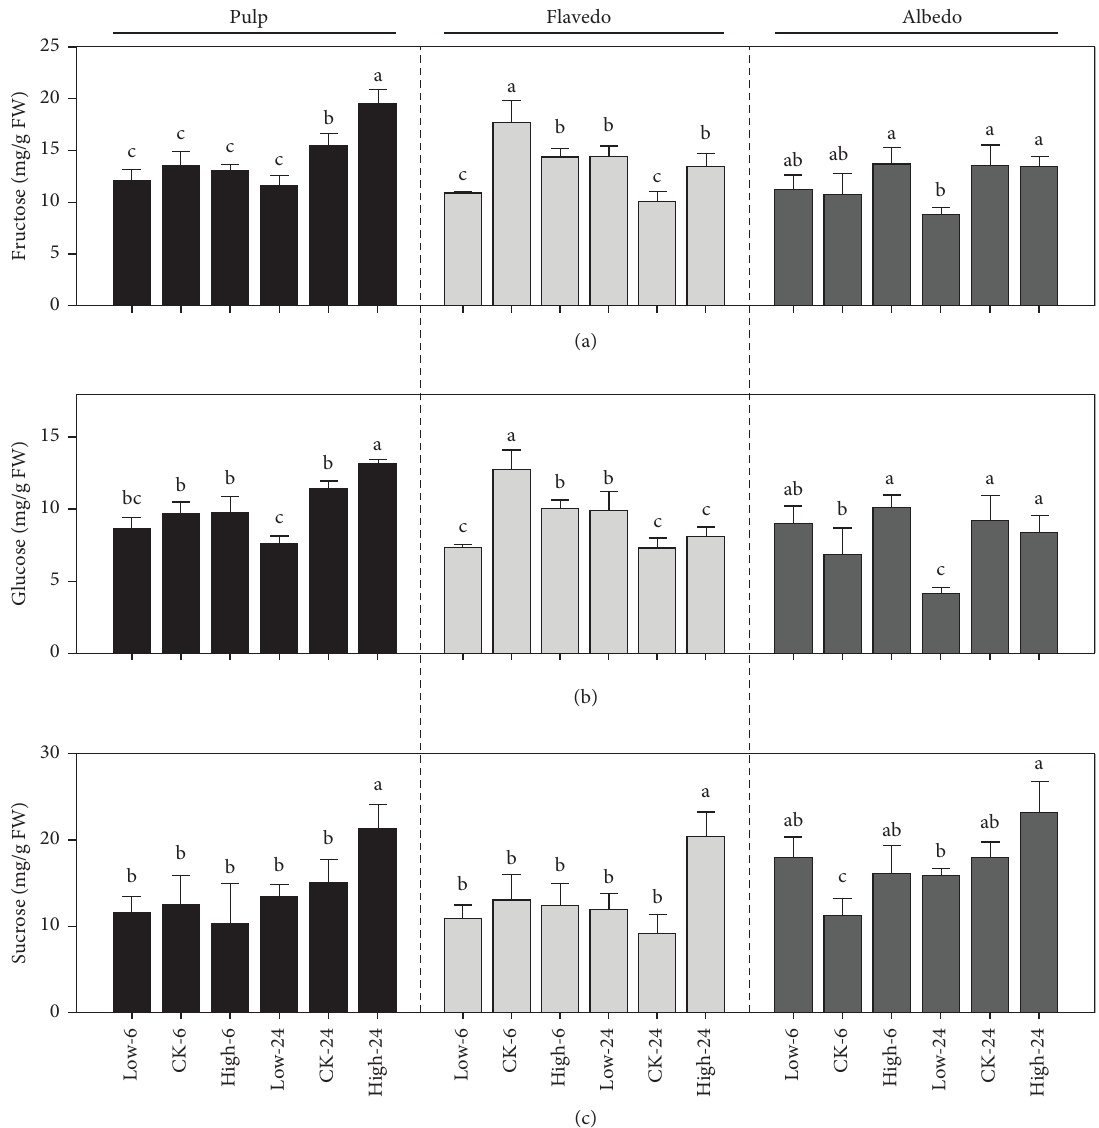
Figure 2: Efects of short-term temperature treatments on sugar contents ((a) fructose; (b) glucose; and (c) sucrose) in the pulp, favedo, and albedo of Valencia orange fruits. Te vertical bars represent the standard errors of the mean. Values with diferent letters within the same fgure are signifcantly diferent according to the ANOVA test at p < 0 .